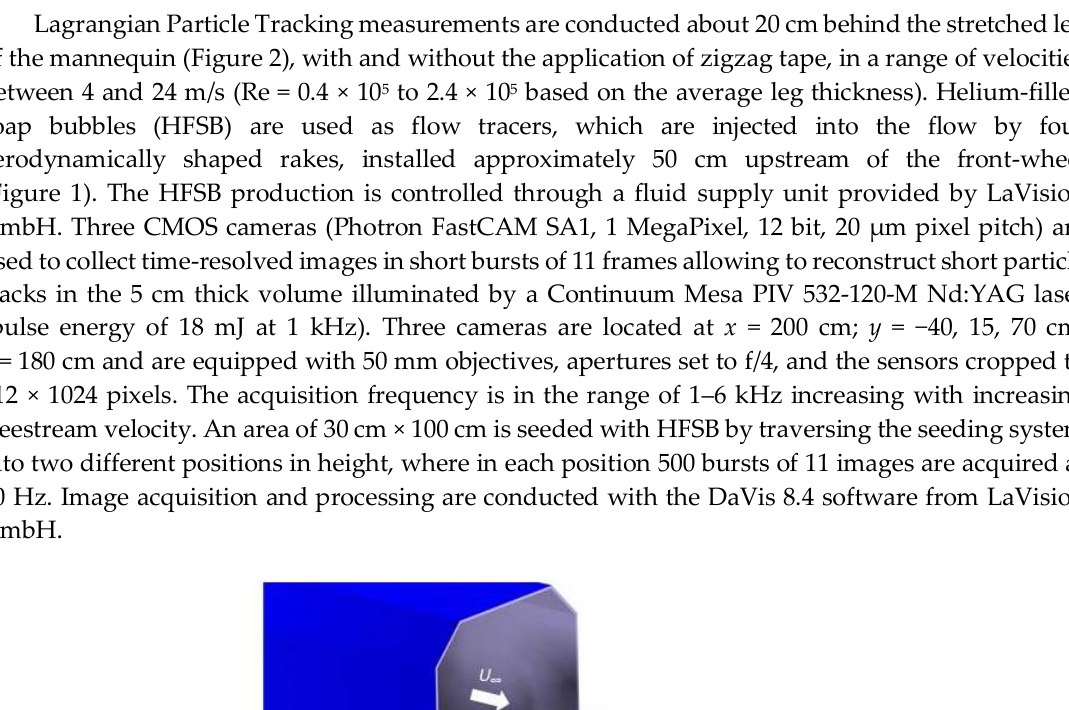
Figure 1. Cyclist and HFSB seeding system ( left ) and the application of zigzag tape on the stretched leg ( right ).